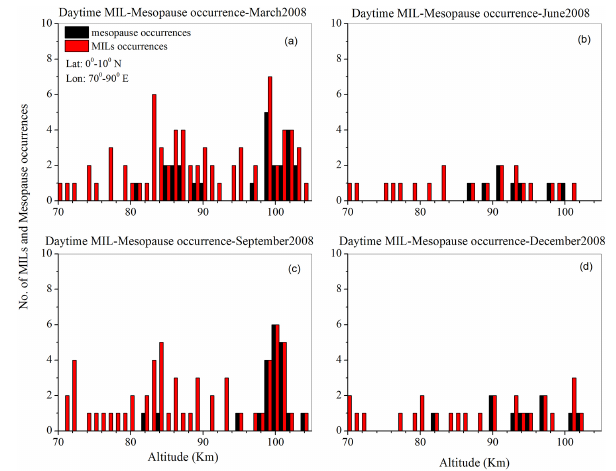
Figure 2. The altitude distribution of the MIL occurrences and the mesopause occurrences for the year 2002 during daytime (a) and night-time (b) and year 2008 during daytime (c) and night-time (d) . The red bars show the MIL occurrences while the black bars rep- resent the mesopause altitudes. One may note that upper inversions do not always represent the mesopause altitudes.